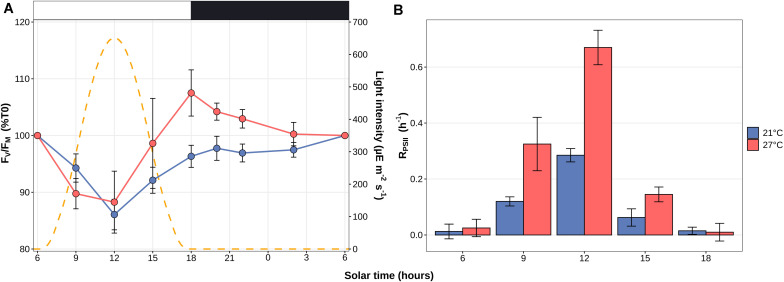
Daily variations of the photosystem II maximal quantum yield (FV/FM) and D1 repair rates for Synechococcus sp. WH7803 cells acclimated to a modulated 12 h/12 h L/D cycle at 21 or 27°C. (A) PSII maximal photochemical yield (FV/FM) expressed as % of FV/FM at 6 a.m. (B) Photosystem II repair rate (RPSII). Note that this parameter was not measured during the night since a previous study showed that there is no repair during this period (Mella-Flores et al., 2012). Light and dark periods (μE m–2 s–1) are indicated by white and gray background on the figure and by a dashed line during the light period showing the modulation of light intensity. Error bars indicate standard deviation for four biological replicates.